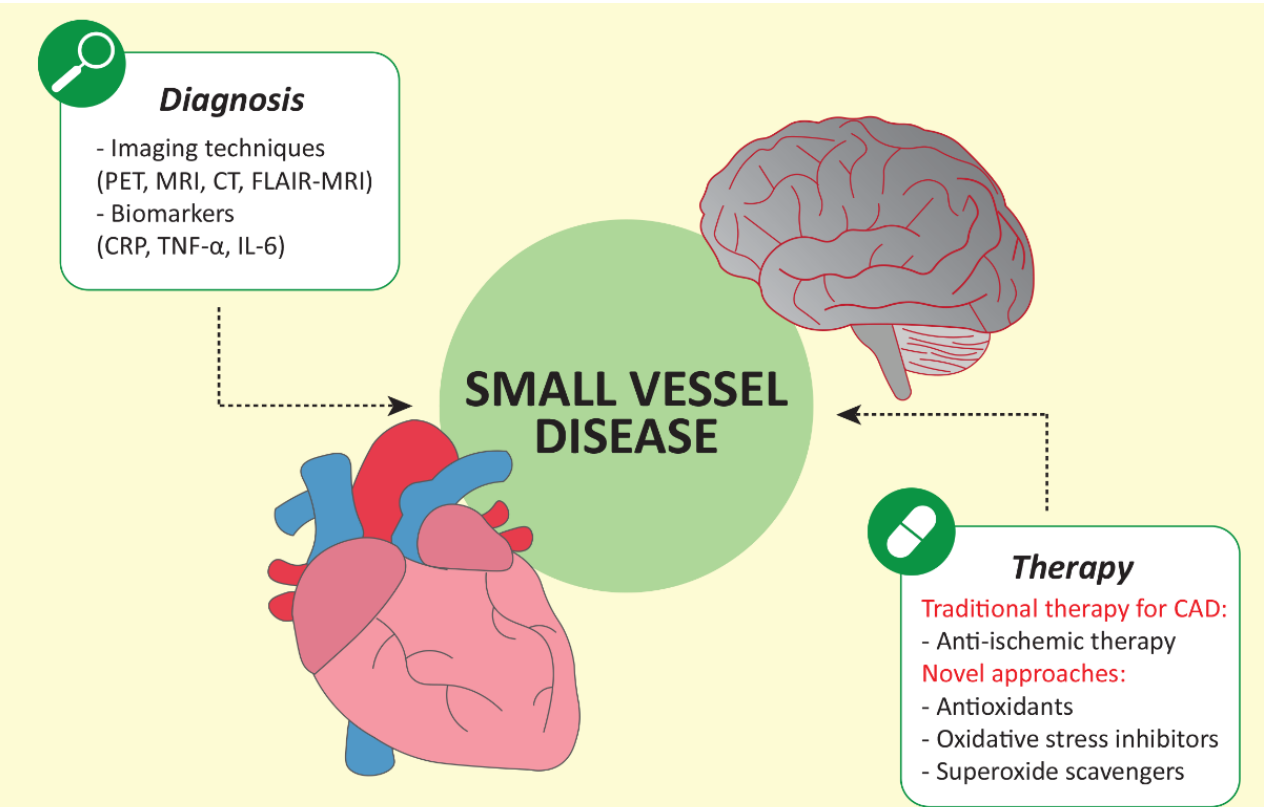
Figure 2. The figure describes diagnostic tools, both the imaging techniques and biomarkers for small-vessel disease, and the current therapeutic approach. CAD, coronary artery disease; CRP, C-reactive protein; CT, computed tomography; FLAIR-MRI, fluid-attenuated inversion recovery magnetic-resonance imaging; MRI, magnetic-resonance imaging; PET, positron-emission tomography; TNF- α , tumor-necrosis-factor α ; IL-6, interleukin.